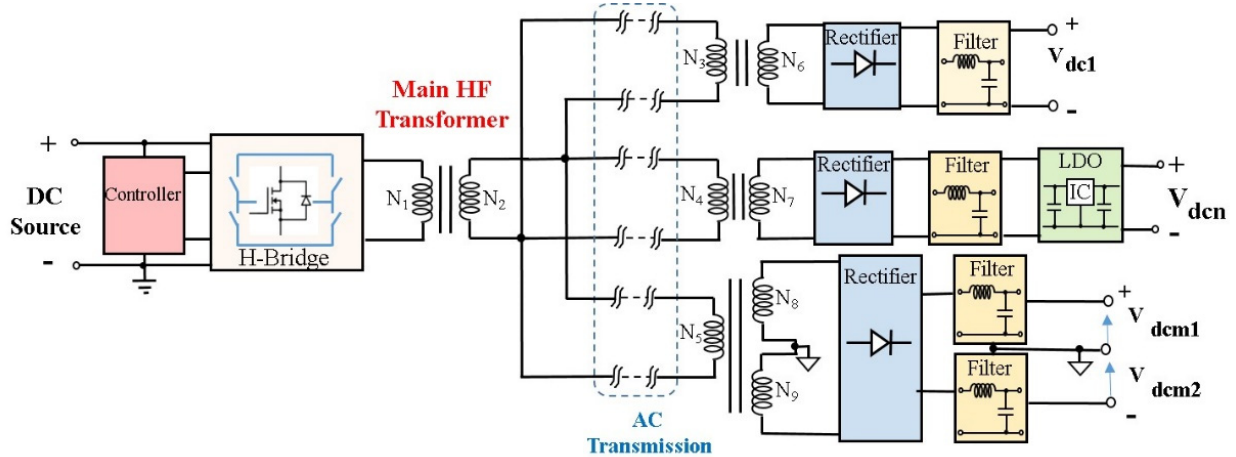
Figure 2. AC distributed auxiliary power supply’s architecture with a main H-Bridge soft-switching converter and HF transformers to obtain the LPS requested low voltage (V dcn ) for the load’s needs. Each secondary circuit is composed of a fast rectifier diode bridge, followed by a low pass filter and a linear or switching regulator, if it is necessary to obtain a more stable and accurate output voltage. Further, in this LPS arrangement, the HF transformer can be with a single voltage on secondary or center-tapped secondary to obtain a dual-voltage